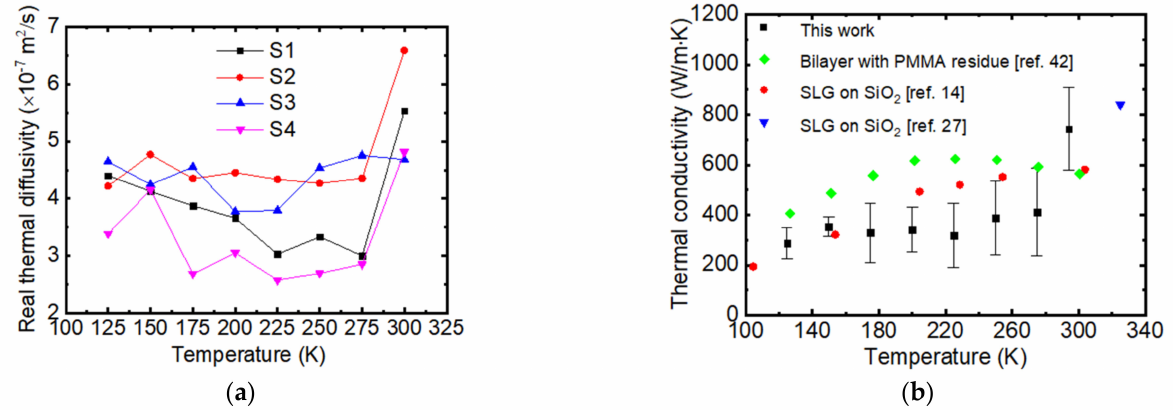
Figure 5. ( a ) Real thermal diffusivity without radiation effect for S1, S2, S3, and S4; ( b ) Thermal conductivity variation against temperature of SLG supported by PMMA. For comparison, the ther- mal conductivities of SLG supported by SiO 2 (Reprinted/adapted with permission from Ref. [14]. Copyright 2010, The American Association for the Advancement of Science) and bilayer graphene with PMMA residue (Reprinted/adapted with permission from Ref. [42]. Copyright 2011, American Chemical